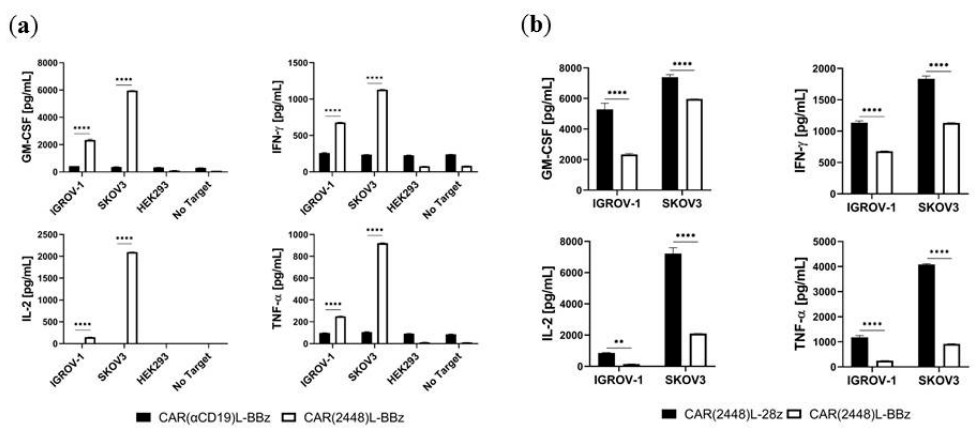
Figure 4. Lentivirally transduced CAR(2448)L T cells mediate cytokine release upon recognition of target cells. Co-incubation of CAR T cells and tumour cells at 10:1 E:T ratio. ( a ) CAR(2448)L-BBz T cells secrete inflammatory cytokines upon recognition of ANXA2 + target cells, but not control CAR( α CD19)L-BBz T cells. Cytokine release above basal level is not observed in co-incubation with ANXA2- cell lines. ( b ) CAR(2448)L-28z T cells secrete significantly higher levels of inflammatory cytokines compared with CAR(2448)L-BBz T cells upon recognition of ANXA2 + target cells. For all subfigures, abbreviations: ** p < 0.01. **** p < 0.0001.